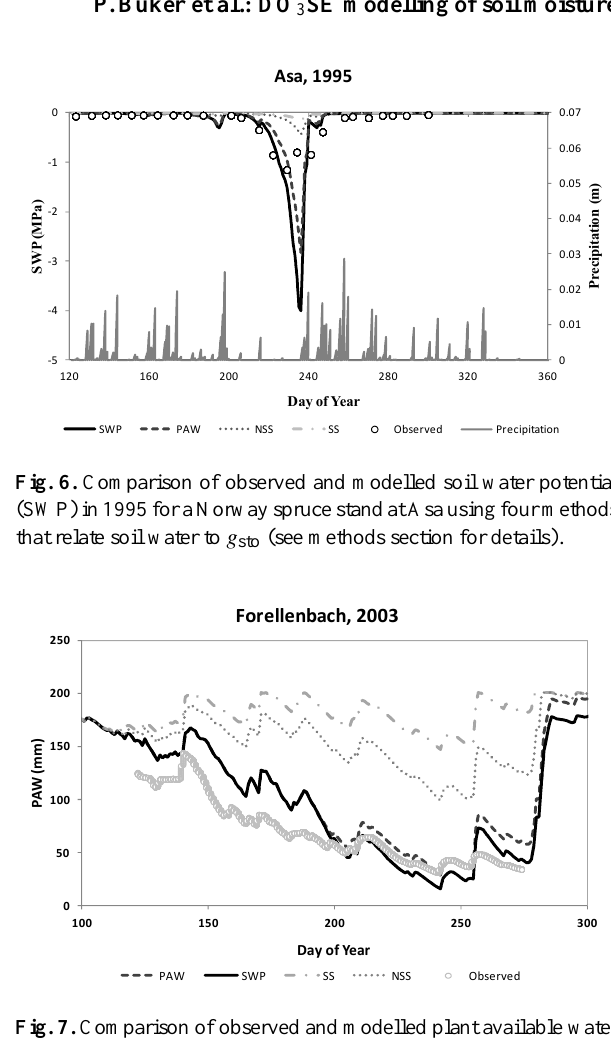
Fig. 7. Comparison of observed and modelled plant available water (PAW) in 2003 for a beech stand at Forellenbach using four methods that relate soil water to g sto (see methods section for